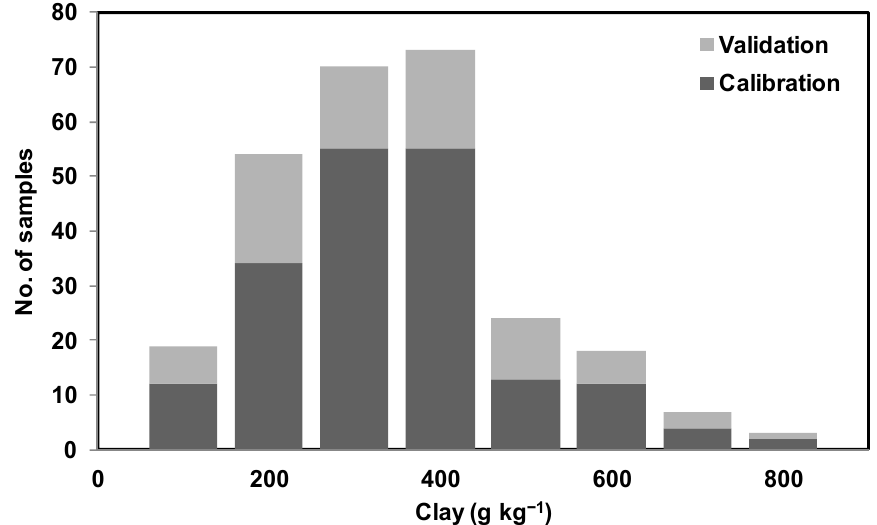
Figure 6. Illustration of distribution of sand content using stacked histogram with two categorical variables (calibration data and validation data).